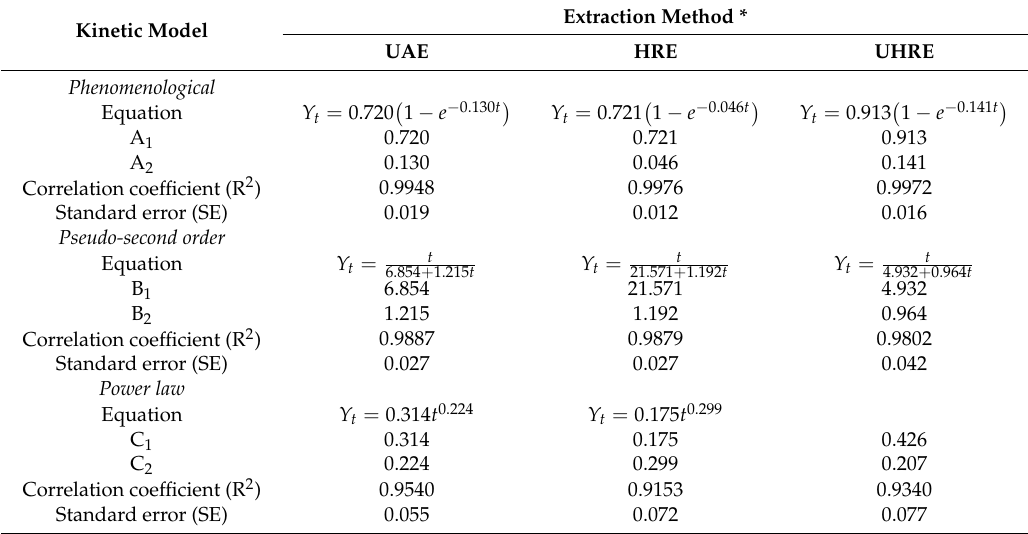
Table 4. The kinetics models and parameters for extraction of flavonoid by UAE, HRE and UHRE. Kinetic